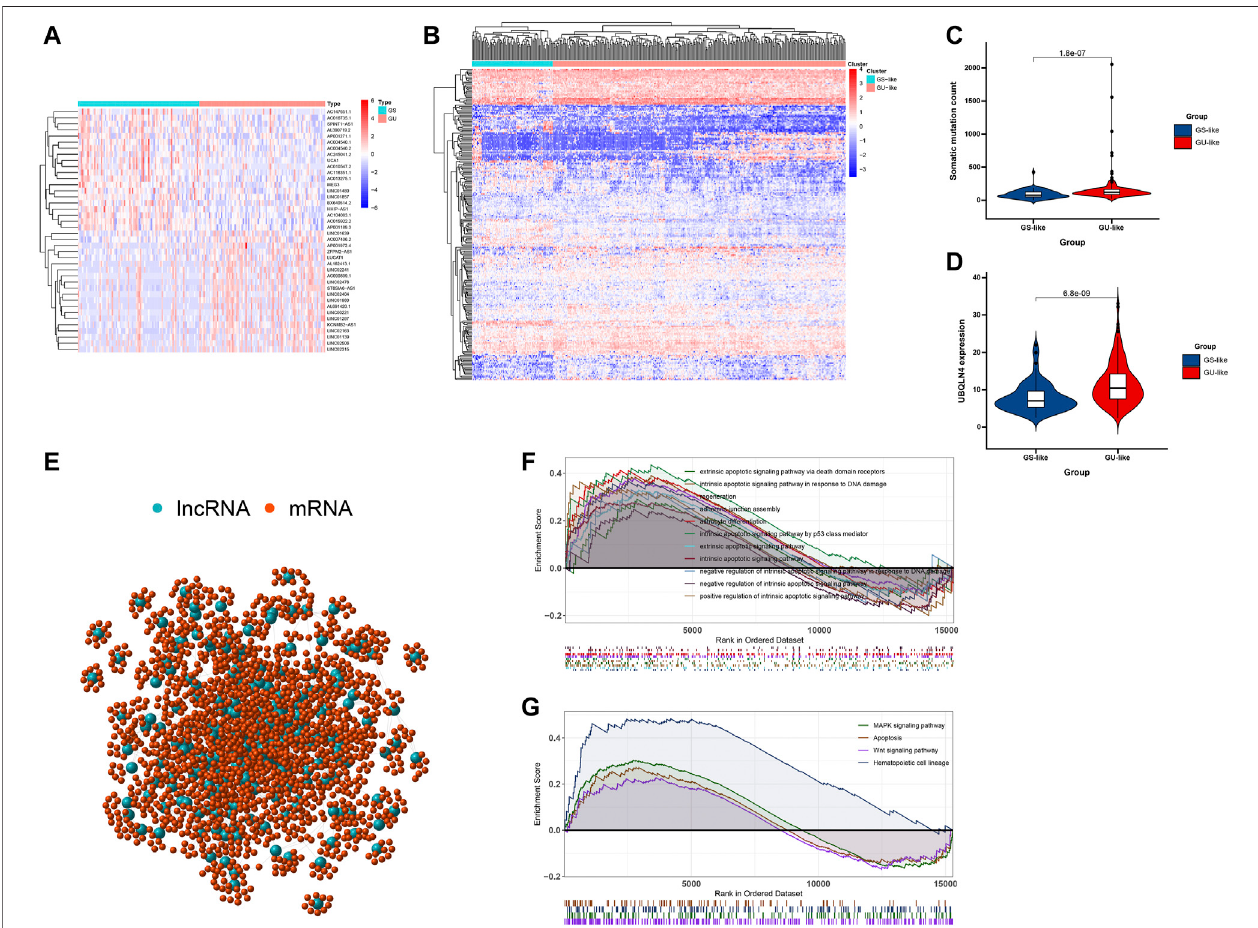
FIGURE 2 | Identi fi cation and functional annotations of genomic instability-related lncRNAs in patients with breast cancer. (A) Heatmap of the top 20 genome instability-associated lncRNAs expressing the most upregulation and downregulation. (B) Unsupervised clustering of 374 HCC patients based on the expression pattern of 245 candidate genomic instability-related lncRNAs. The left blue cluster is GS-like group, and the right red cluster is GU-like group. (C) Boxplots of somatic mutations in theGU-like group and GS-like group. Somatic cumulative mutations in theGU-like group are signi fi cantly higher than those in the GS-like group. (D) BoxplotsofUBQLN4 expression levelin theGU-like group and GS-likegroup. Theexpression levelofUBQLN4 in the GU-likegroup is signi fi cantly higher than that in the GS-like group. Horizontal lines: median values. Statistical analysis was performed using the Mann – Whitney U test. (E) Coexpression network of genomic instability-related lncRNAs and mRNAs based on the Pearson correlation coef fi cient. The red circles represent lncRNAs, and the blue circles represent mRNAs. (F) Functional enrichment analysis of GESA GO for mRNAs co-expressed lncRNAs. (G) Functional enrichment analysis of GESA KEGG for mRNAs co- expressed